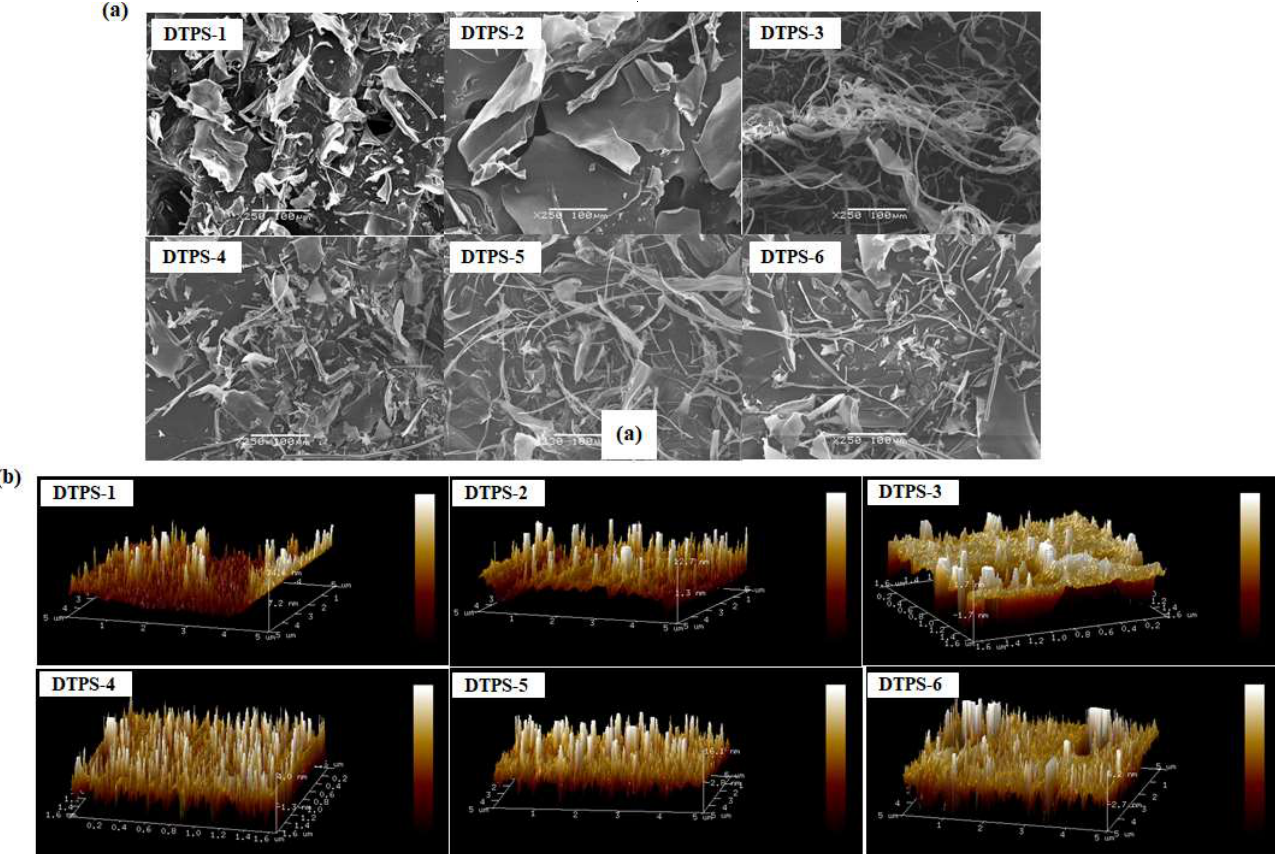
Figure 4. SEM ( a ) and AFM ( b ) images of the DTPSs.